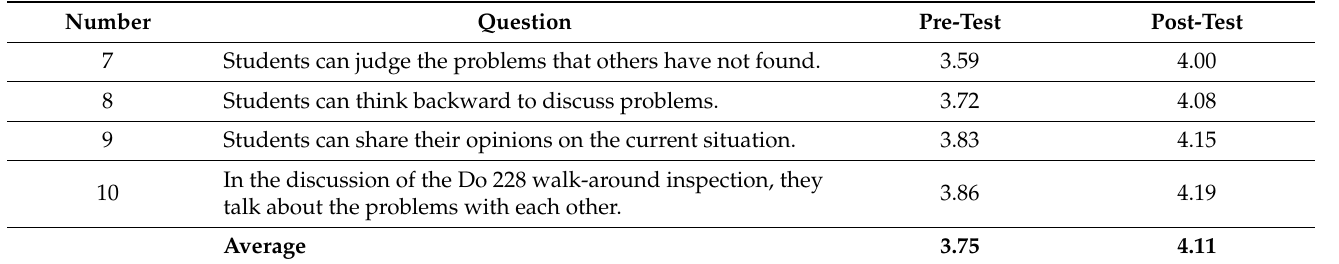
Table 5. Results for the problem comment